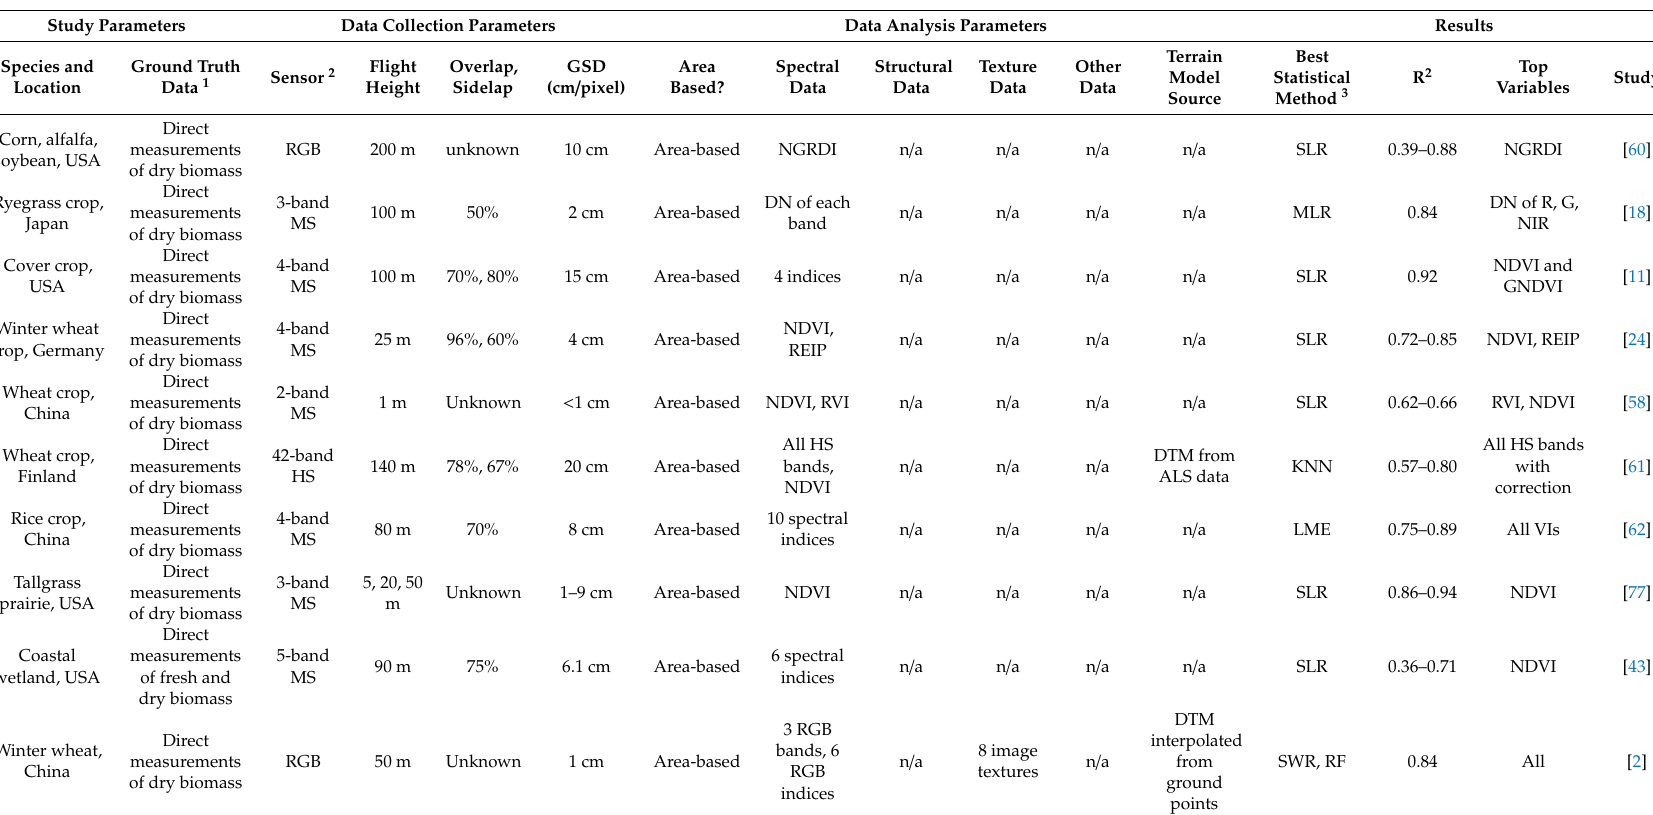
Table A1. A summary of the 46 studies assembled for this review. Items recorded include study species and location, ground truth data type, UAS type, sensor type(s), flying height, photo overlap and sidelap, ground sample distance (GSD), whether analysis was done on an area-based plots or individual plants, spectral input data used, structural input data used, textural input data used, any other input data used, ground model source, best statistical model type, R 2 of top calibration model and top